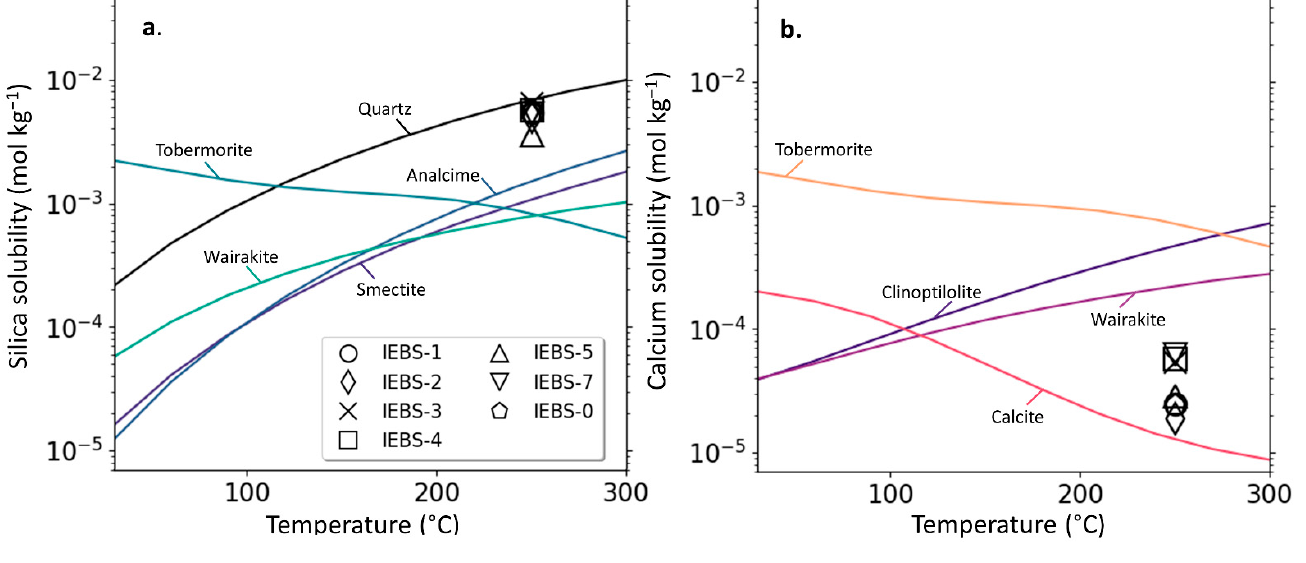
Figure 6. Silica and calcium solubility in solution with respect to select minerals identified in the initial and/or post-mortem reactants, at pH 7.75 and 15 MPa. ( a ). Silica solubility for select minerals and silica concentrations for samples collected at ~1000 h from each experiment, and ( b ). calcium solubility for select minerals and calcium concentrations from the same samples plotted in ( a ).